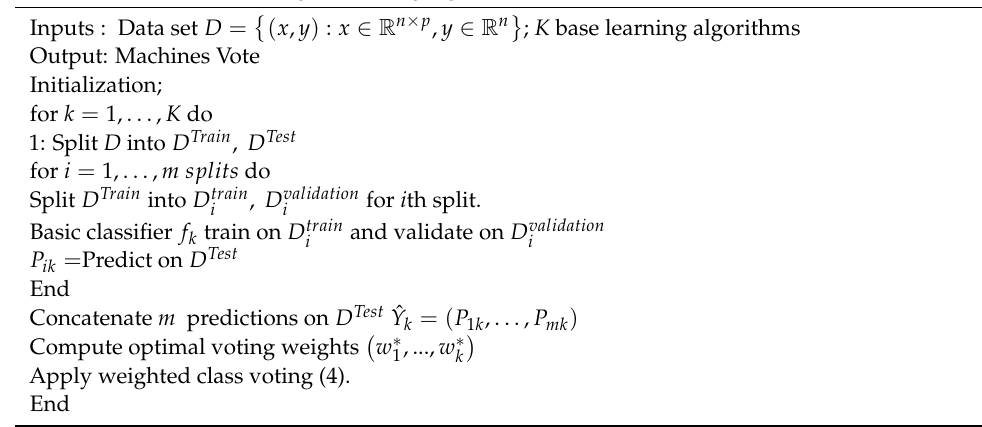
Algorithm 1: Machine-weighted voting